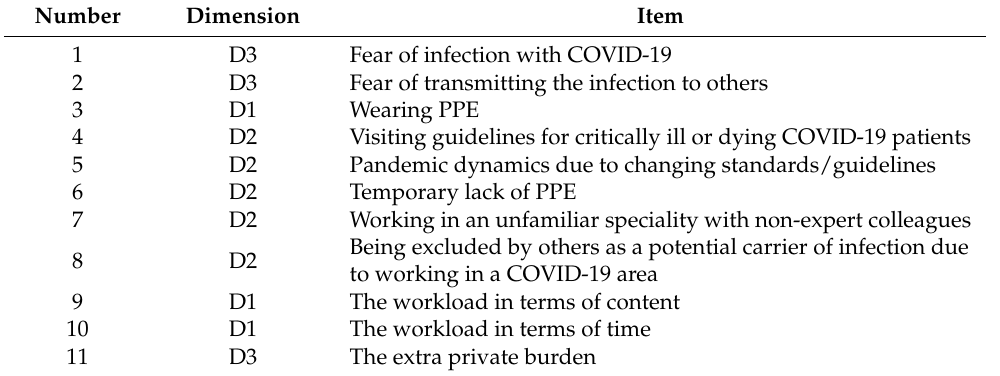
Table 9. Stress Scale and